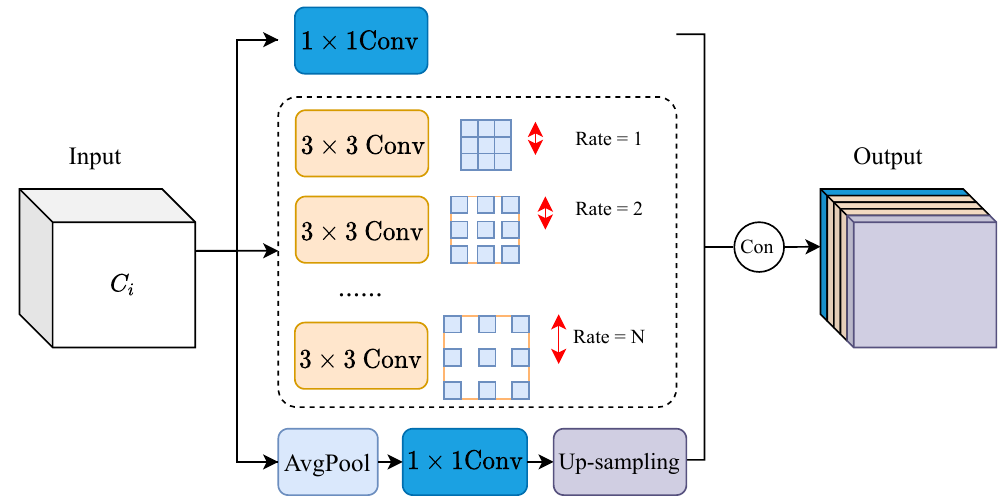
Figure 3. The architecture of the Context Collector [19] adopted in this